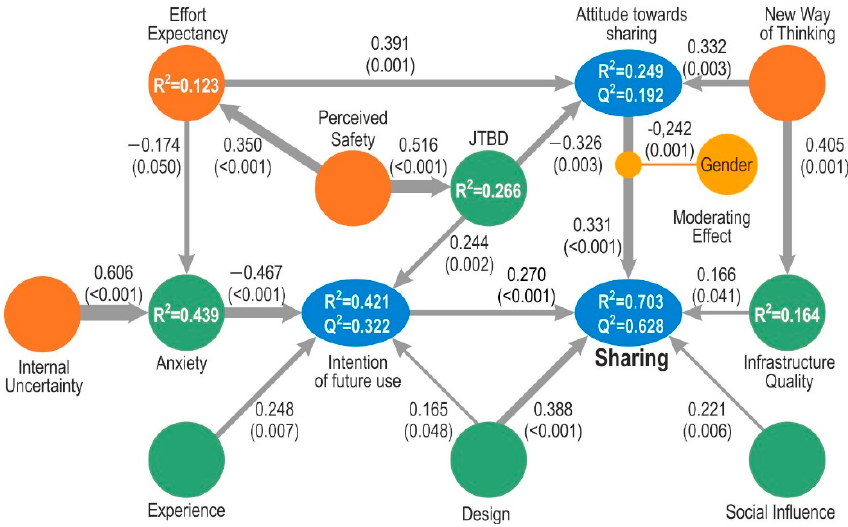
Figure 3. Structural model of e-scooter sharing. (Source: generated by the authors based on PLS-SEM in SmartPLS) N.B.: The path coefficients are shown on the arrows and p -levels are in brackets. Source: generated by the authors.